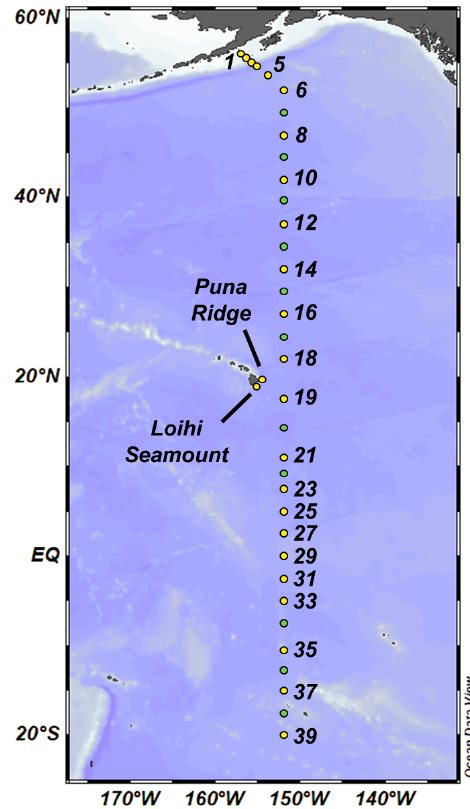
Figure 1. GEOTRACES GP15 expedition track. Leg 1 (RR1814, September–October 2018) spanned between the Alaskan coast and Hawaii, and Leg 2 (RR1815, October–November 2018) spanned between Hawaii and 20 ◦ S. Yellow points represent full-depth sta- tions, and green points represent demi stations where only the upper 1000m was sampled. At Station 11, only a surface towfish ( ∼ 2m) sample was